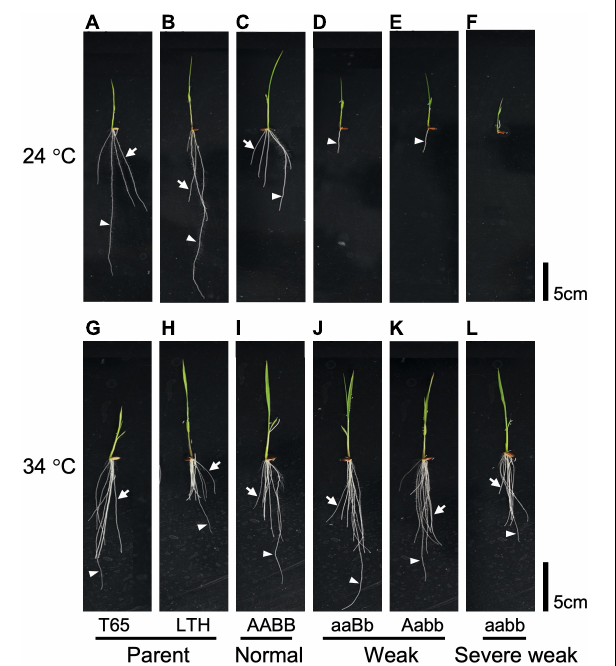
FIGURE 7 | Morphology of 10-day-old seedlings grown under different temperatures. Seedlings grown at 24 ◦ C (A) T65, (B) LTH, (C) normal genotype, (D,E) weak genotypes, and (F) severe weak genotype; seedlings grown at 34 ◦ C (G) T65, (H) LTH, (I) normal genotype, (J,K) weak genotypes, and (L) severe weak genotype. Arrowheads point primary root. Arrows point crown root. Scale bars = 5